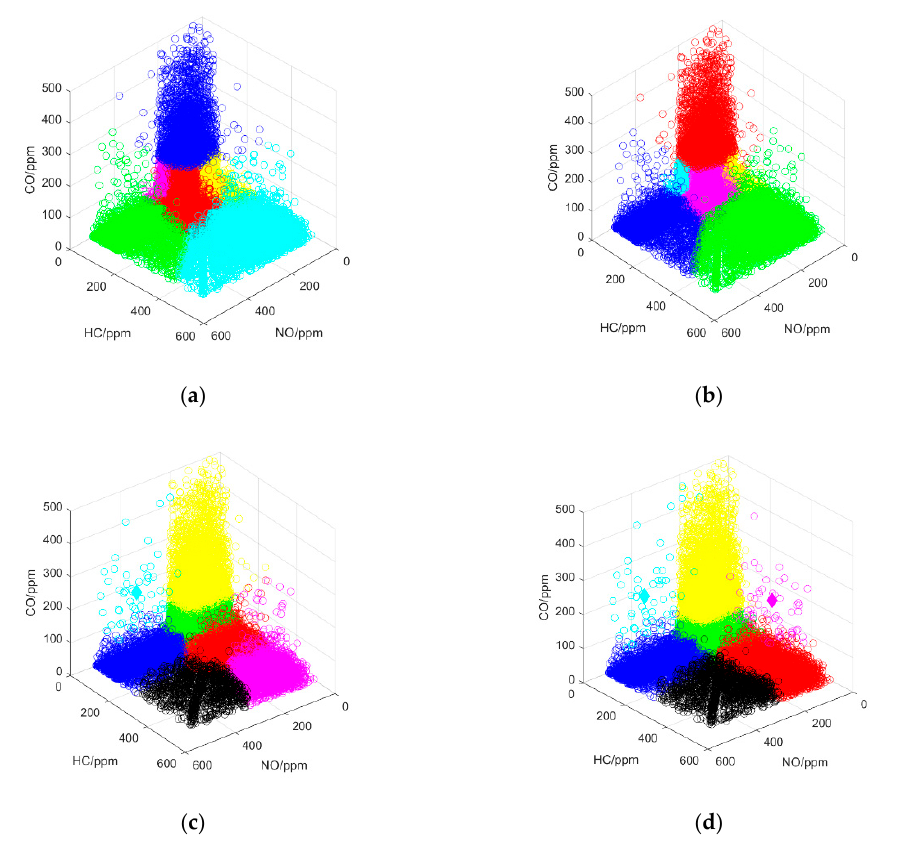
Table 2. The performance test of different clustering algorithms. Emission Dataset